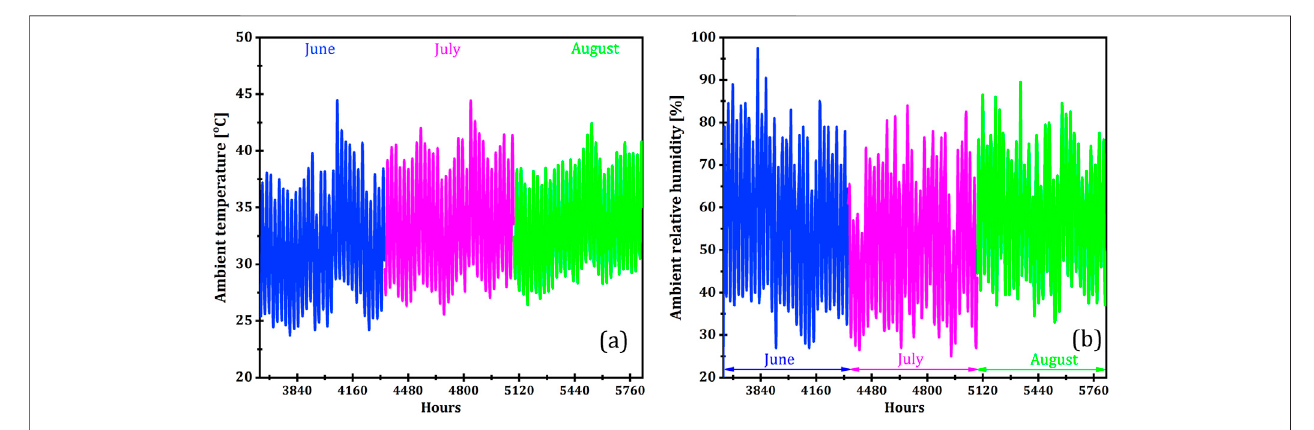
FIGURE 2 | Ambient properties (Jeddah, 21.48 ° N, 39.19 °